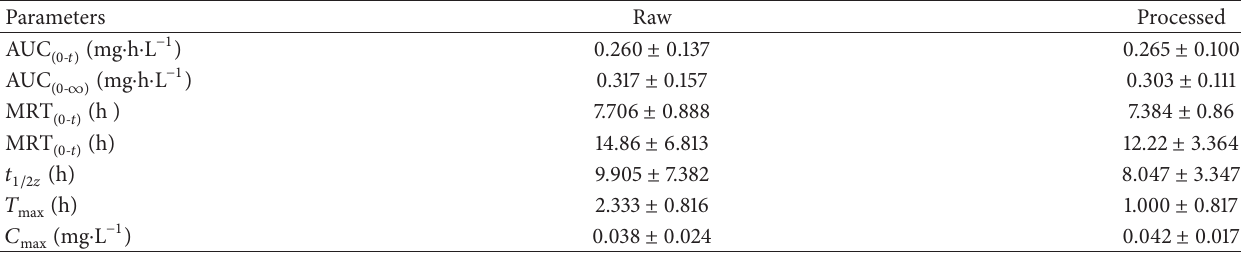
Table 2: The pharmacokinetic parameters of (4 E ,6 E ,12 E )-tetradecatriene-8,10-diyne-1,3-diyl diacetate of raw and processed AtractylodisRhi- zoma at a dose of 40g ⋅ kg − 1 to rats, respectively ( 𝑛 = 6 ).